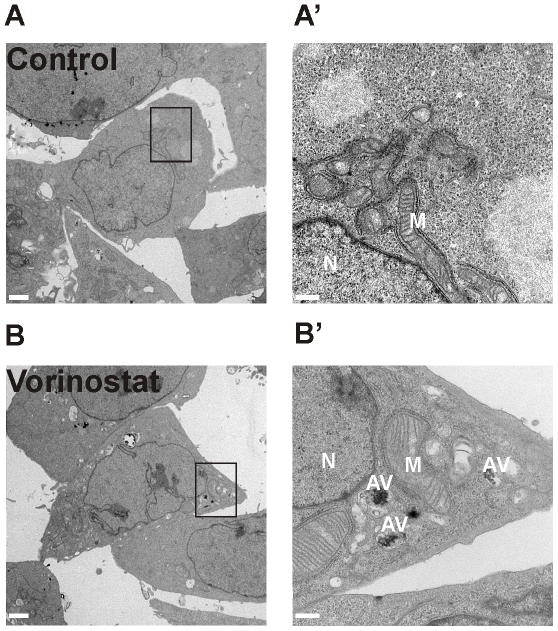
Electron microscopy analysis of autophagy in AGS cells.After 12 h treatment DMSO (A, A') or with 5 µM vorinostat (B, B') (left panels, low magnification, scale bar: 2 µm), EM analysis was performed. High magnification images of boxed areas with Av depicting autophagic vacuoles (left panels, scale bar: 500 nm; N: nucleus, M: mitochondria).